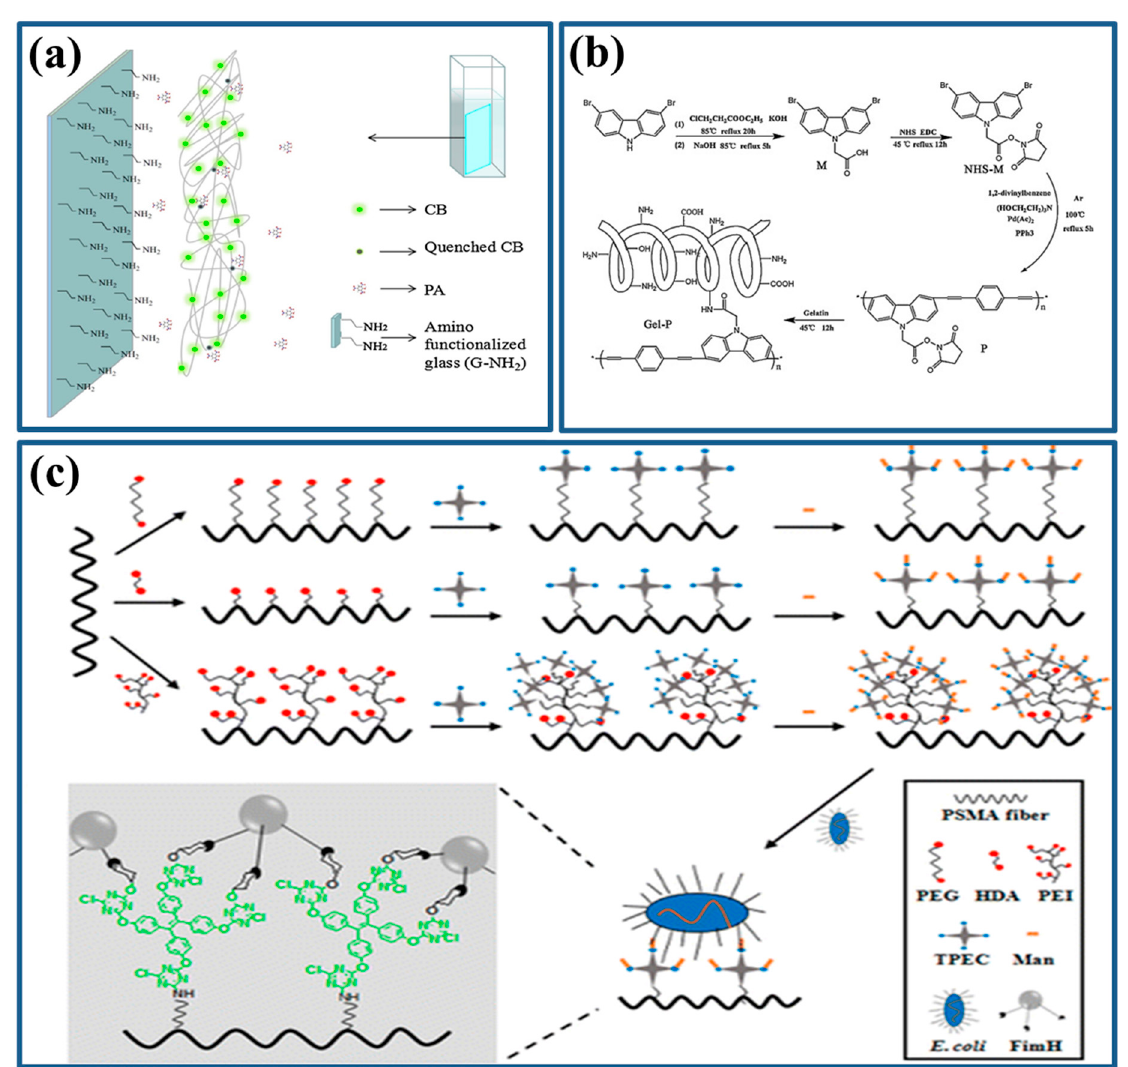
Figure 3. ( a ) 5-(N-carbazole styryl)-1,3-dimethyl-barbituricacid (CB)- polystyrene (PS) / G-NH 2 sensor fabrication in detecting picric acid. Reprinted from work in [3] with permission from Elsevier. ( b ) Mechanistic view of forming gel-P using synthesized polymer P grafted onto the gelatin. Adapted from work in [89] with permission from Elsevier. ( c ) Simple representation demonstrating the receptor grafting process takes place on the copolymeric Polystyrene-co-maleic anhydride (PSMA) nanofiber giving rise to the development of optical sensory fibers. Adapted from work in [90] with permission from American Chemical Society.